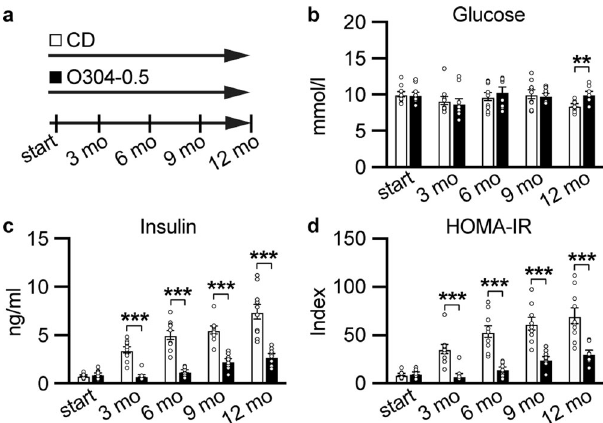
Fig. 1 O304 prevents hyperinsulinemia and insulin resistance in aging mice. a Timeline in months (mo) for mice fed control diet (CD) or CD supplemented with 0.5 mg/g O304 (O304-0.5) from 6 months of age. b – d Fasted glucose ( b ), and insulin ( c ), levels as well as HOMA-IR calculations ( d ) (based on glucose and insulin levels in ( b ) and ( c )), in mice fed CD ( n = 9 – 10) or O304-0.5 ( n = 8 – 10) for 12 months. Data are presented as mean ± s.d. where ** P ≤ 0.01, and *** P ≤ 0.001 between CD and O304-0.5 at the time points indicated in the fi gure (two-tailed Mann – Whitney